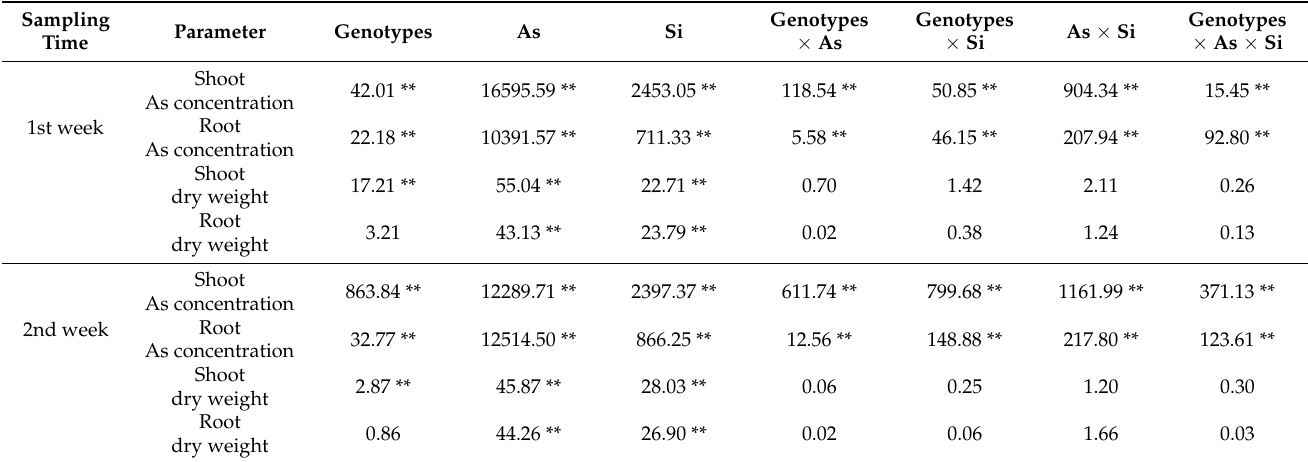
Table 2. ANOVA results due to As, Si, rice genotypes, and their interactions on the As concentration and dry weight of DU-WT and DU-OE shoots and roots at different sampling